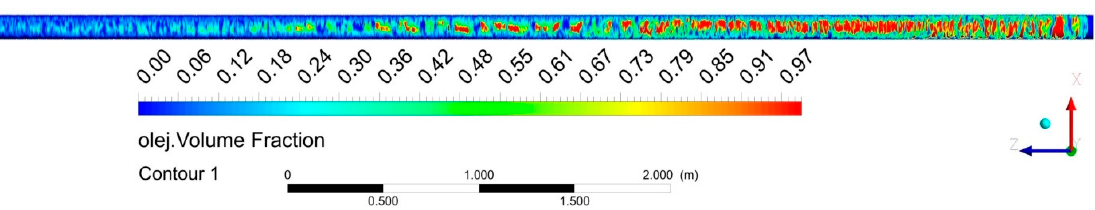
Figure 7. Volume of the oil at the surface of the pipe over its full length at the speed of 7 m / s with a pipe diameter of 25 mm.